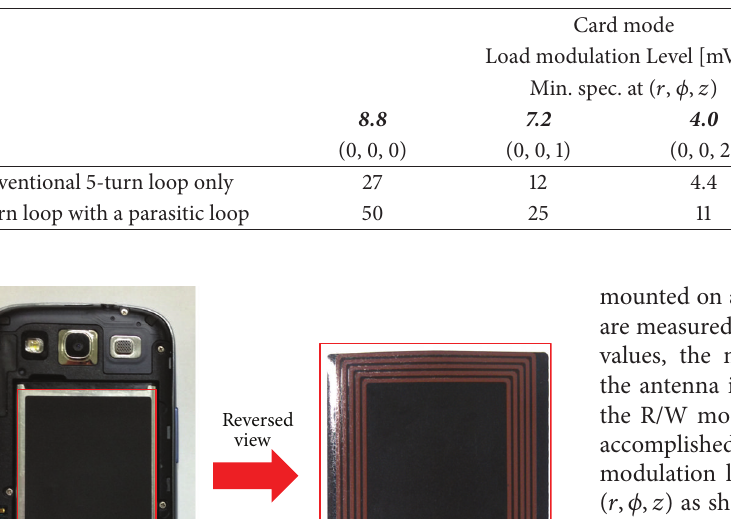
Table 2: Measured results in the card mode and in the R/W mode tests.